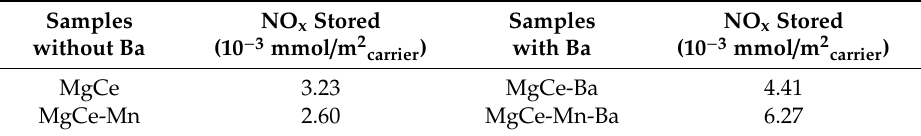
Table 4. Amounts of NO x stored on the samples in dual-bed experiments.